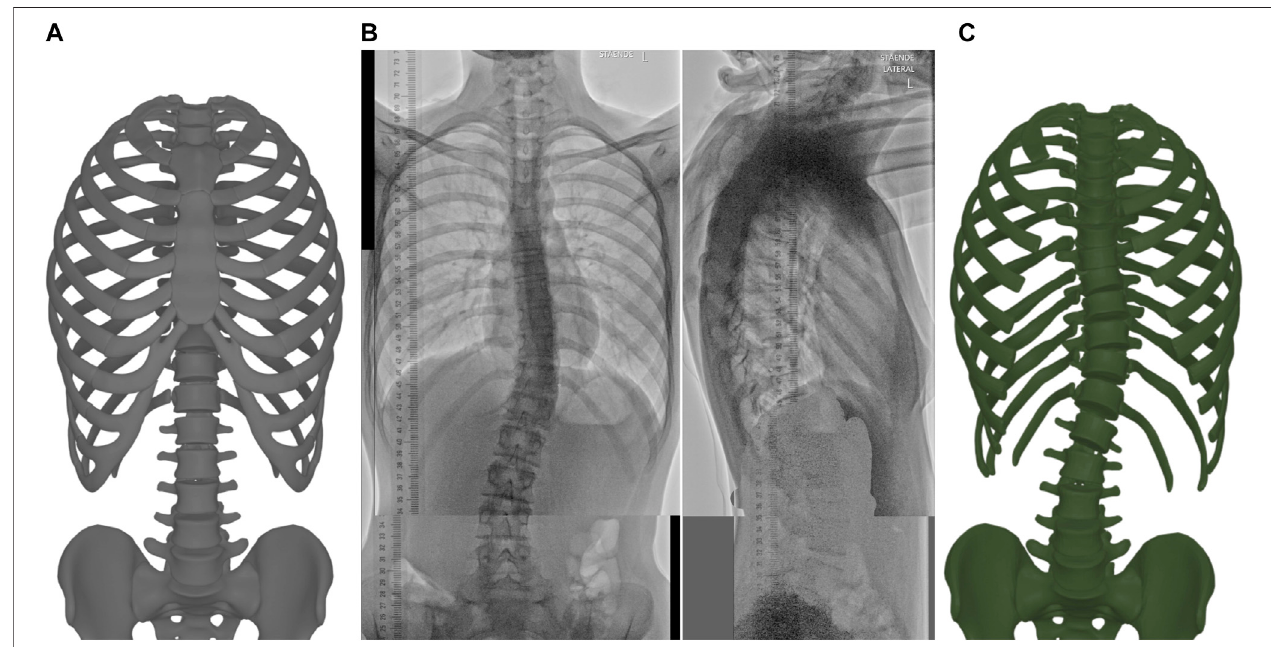
FIGURE 1 | The proposed method takes as input a template model of the torso skeleton (A) and biplanar low-dose radiographs (B) , and outputs the morphed torso skeleton (C) . Here we hide the sternum and the costal cartilages to clearly show the